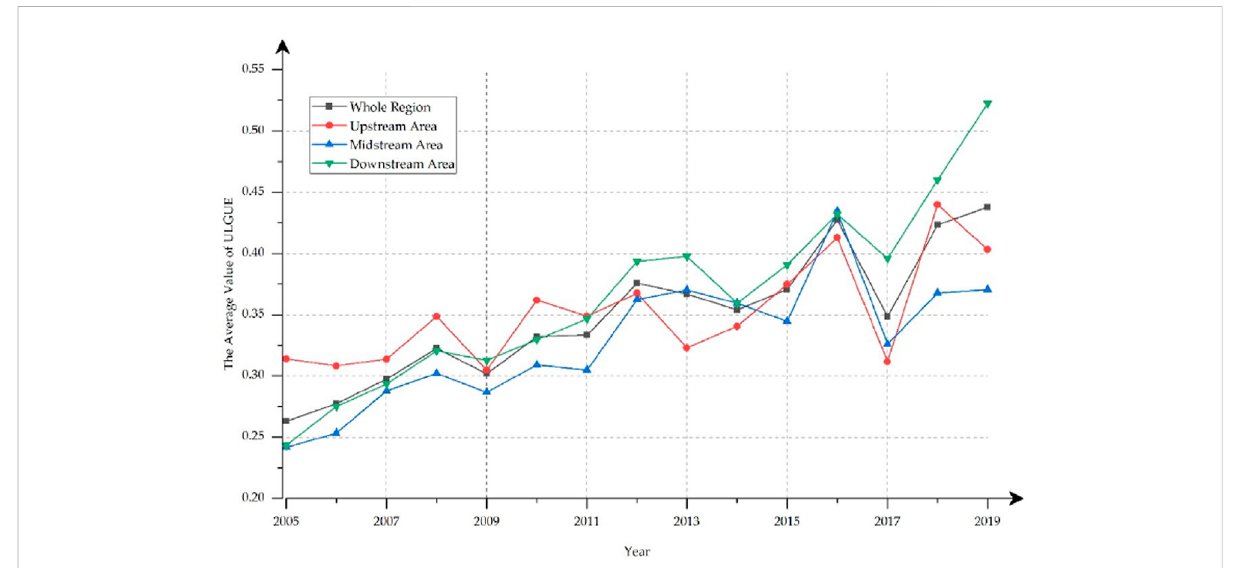
FIGURE 2 Time series trend of ULGUE in the Yangtze River Economic